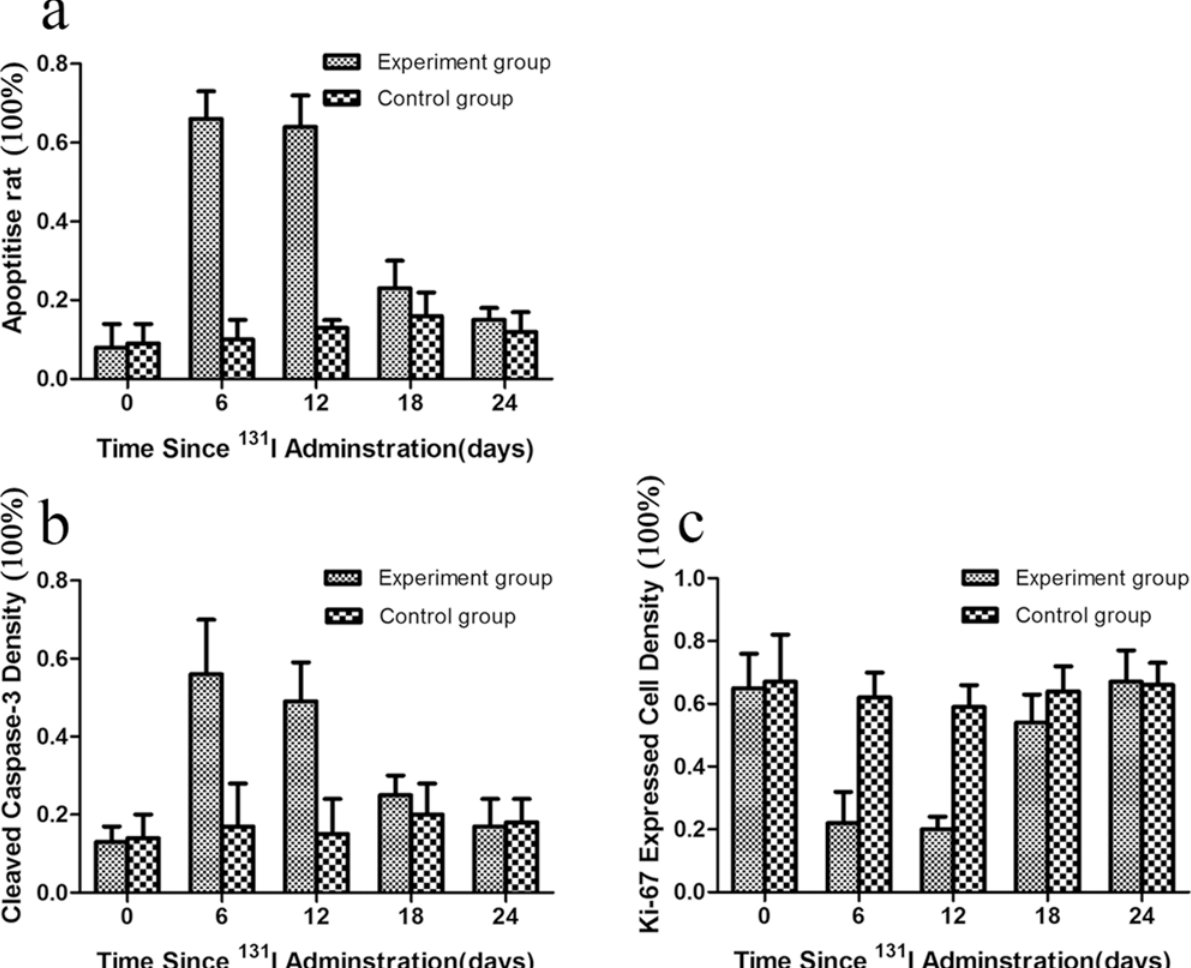
Figure 4. The graphs show apoptotic and proliferating cell density. The graphs show apoptotic cell density (a), cleaved caspase-3 density(b), and proliferating(Ki-67 expression) cell density(c) in xenografts at 0 – 24 days after 131 I treatment in experiment group and control